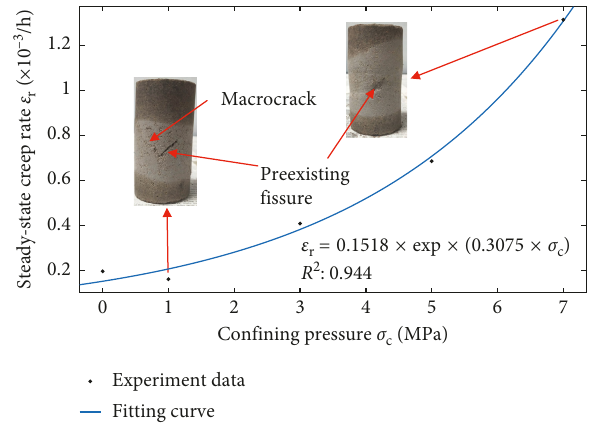
Figure 10: Steady-state creep rate at different confining pressures (T � 20 ° C).